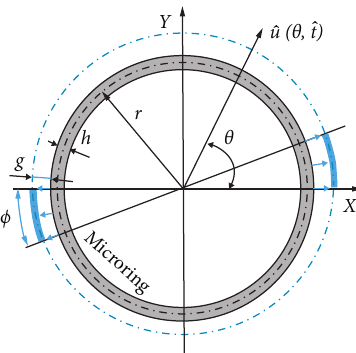
Figure 1: Schematic diagram of electrostatically driven